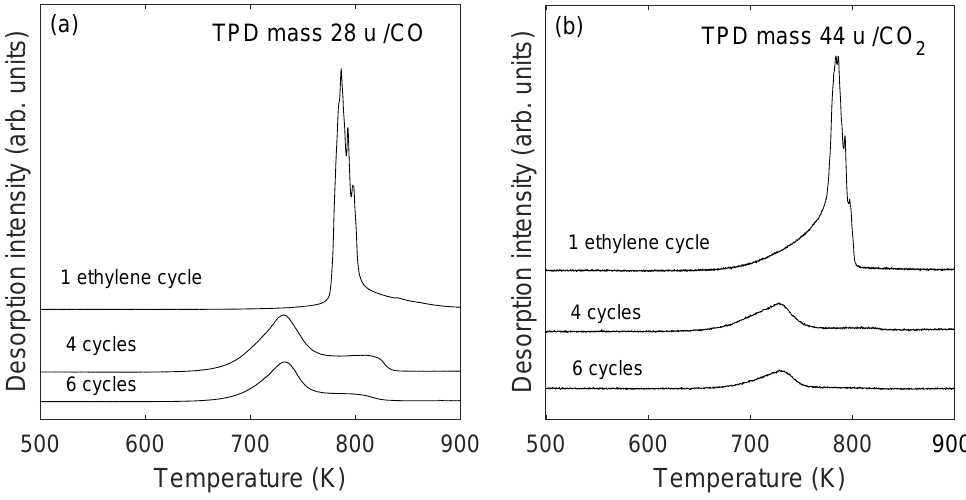
Figure 5. ( a ): TPD of carbon monoxide (mass 28 u), and ( b ) TPD of carbon dioxide (mass 44 u) after exposure to 200 L oxygen at 675 K of graphene/Ru(0001) samples. The ethylene exposure was as indicated on each spectrum (see text).